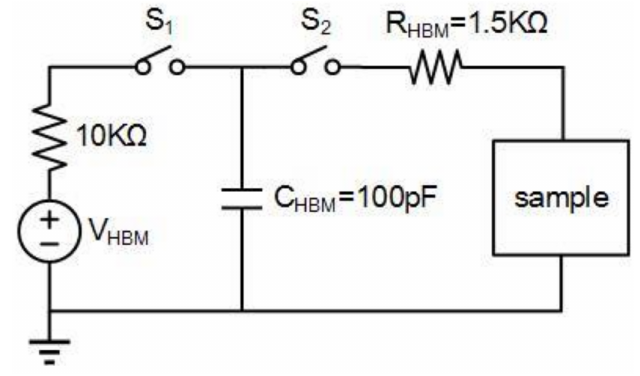
Figure 4. Schematic of a simplified HBM stress ESD model.